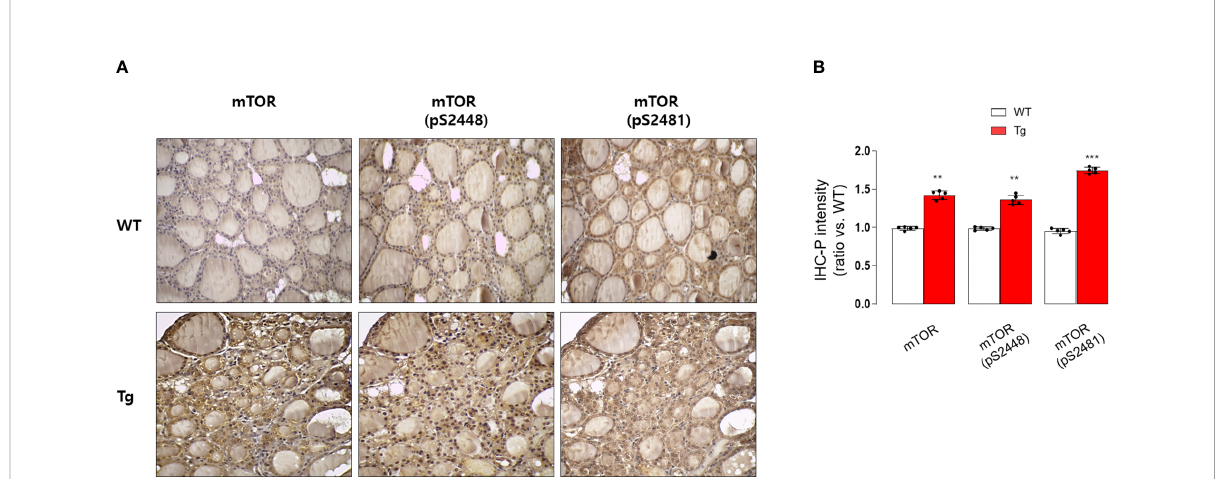
FIGURE 5 Immunohistochemical staining analysis of mTOR, pS2448 mTOR, and pS2481 mTOR in the thyroid glands from wild type (WT) and GDF15 transgenic (Tg) mice (each group n = 5). (A) Representative results of IHC staining (original magni fi cation 200×). (B) Quanti fi cation analysis of intensities (compared with thyroid gland from wild type mice). **p-value < 0.01, ***p-value < 0.001 (indicates a statistically signi fi cant difference from non-parametric Mann-Whitney